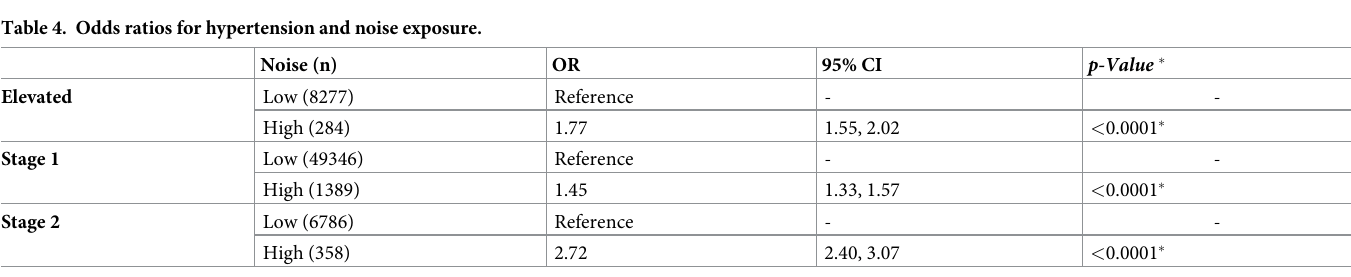
Table 4. Odds ratios for hypertension and noise